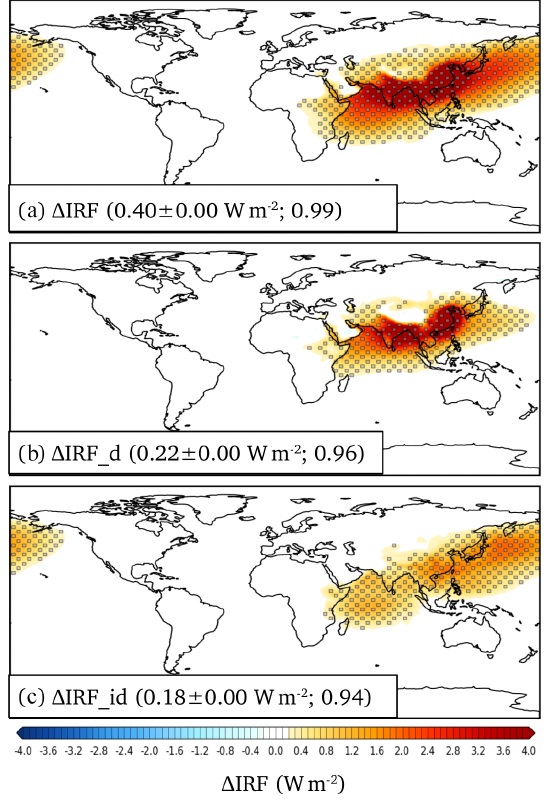
Figure 1. The change in the mean instantaneous radiative forcing between runs without and with South and East Asian aerosols us- ing the MACv2-SP aerosol scheme, averaged over the two climate models (individual models shown in Fig. A1). Parentheses show the average global-mean value and the model-to-model correlation coefficient, respectively. (a) Change in the total aerosol radiative forcing, (b) change in the direct aerosol radiative forcing, and (c) change in the indirect aerosol radiative forcing. Stippling shows re- gions where the results are statistically significant at the p < 0 . 05 level for both models, and models also agree on the